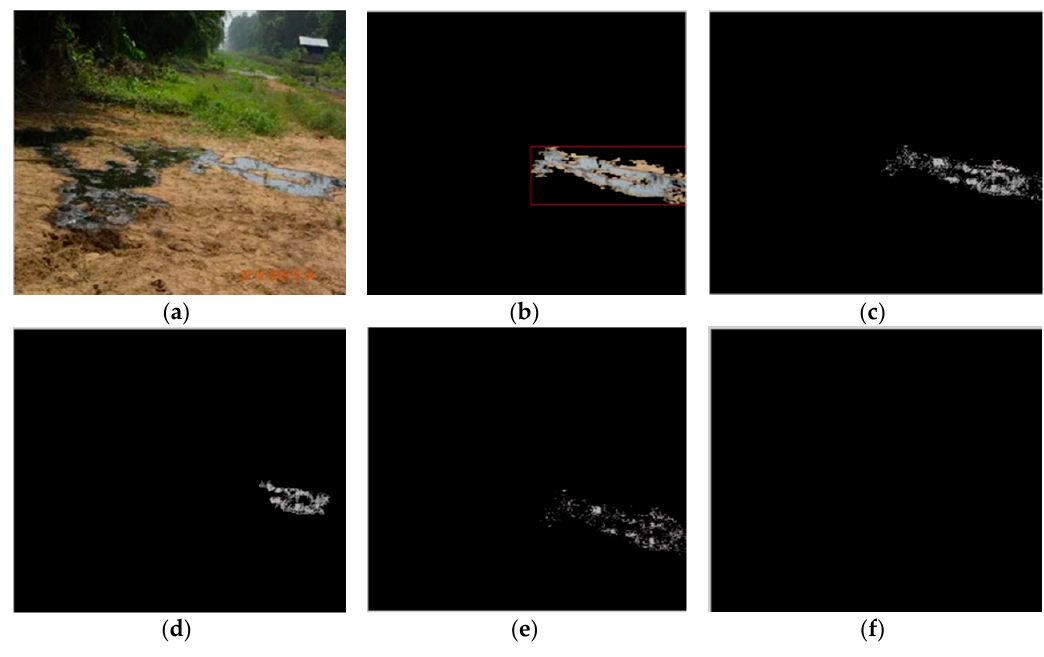
Figure 9. ( a ) Case Image OS28; ( b ) Primary ROI in OS28 identified for further analysis; ( c ) Pixels meeting homogeneity range of Mean − 5 to Mean +5; ( d ) Final Homogeneity ROI derived from ( c ); ( e ) Pixels meeting homogeneity range of Mean − 2 to Mean +2; ( f ) Final Homogeneity ROI derived from ( e )